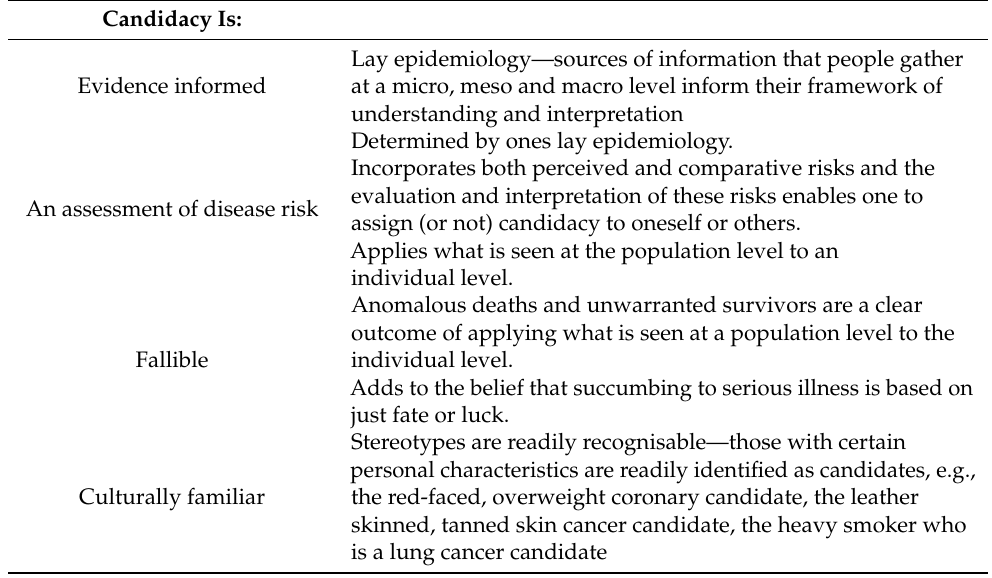
Table 1. Components of Candidacy.